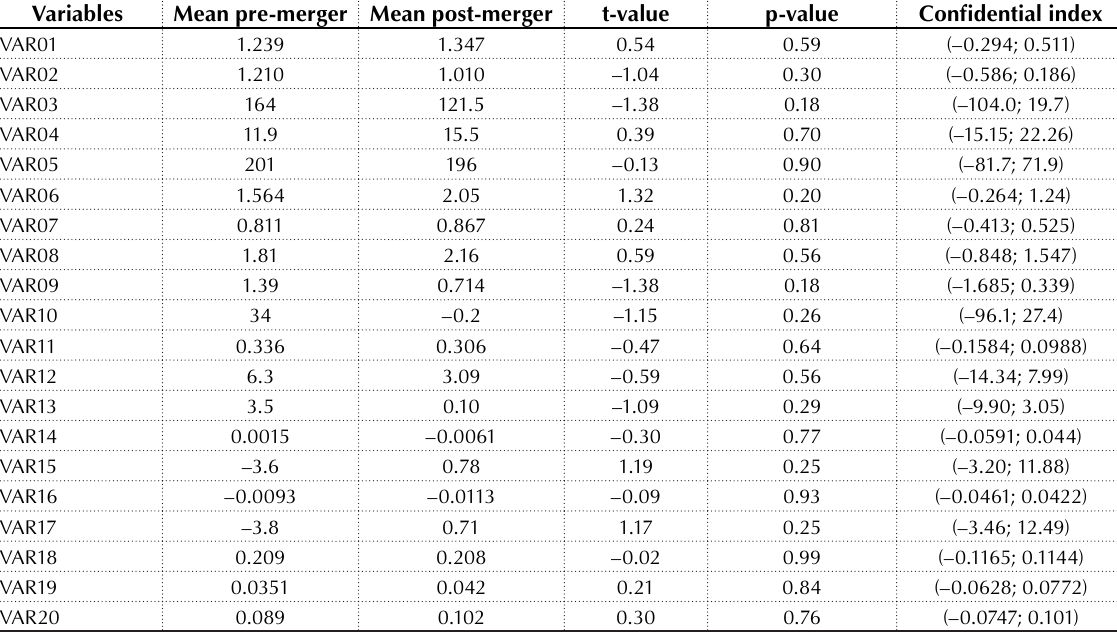
Table 4. Comparison results for 20 ratios from pre- and post-merger period ( H1 )